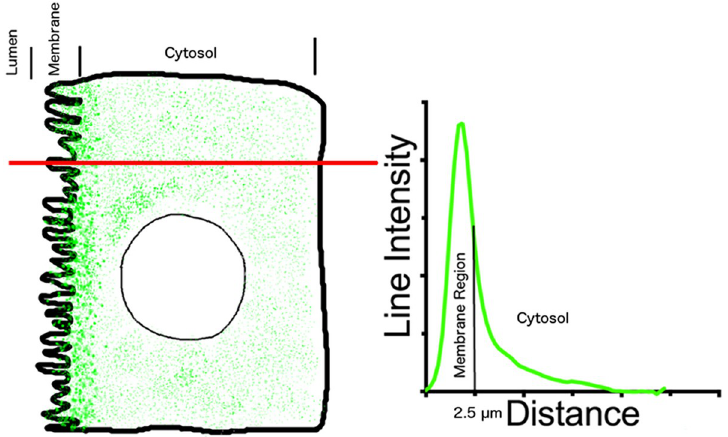
Fig 1. How we measured the line intensity and area under the curve. A line of 0.5 μ m was drawn across cells adjacent to the nucleus and pixel intensity was averaged along the line. The pixel value of the line that fell within the tubule lumen was considered as background, and the mean value from this segment of the line was subtracted from all line intensity values. The lumen-membrane junction was considered 0 distance. Total area under the curve was calculated and normalized to 100%, and percentage of area under the curve from 0 to 2.5 μ m was considered as the area that included the apical membrane domain. This area calculation informs us about the fraction of total AQP2 in or near the cell membrane in a given optical